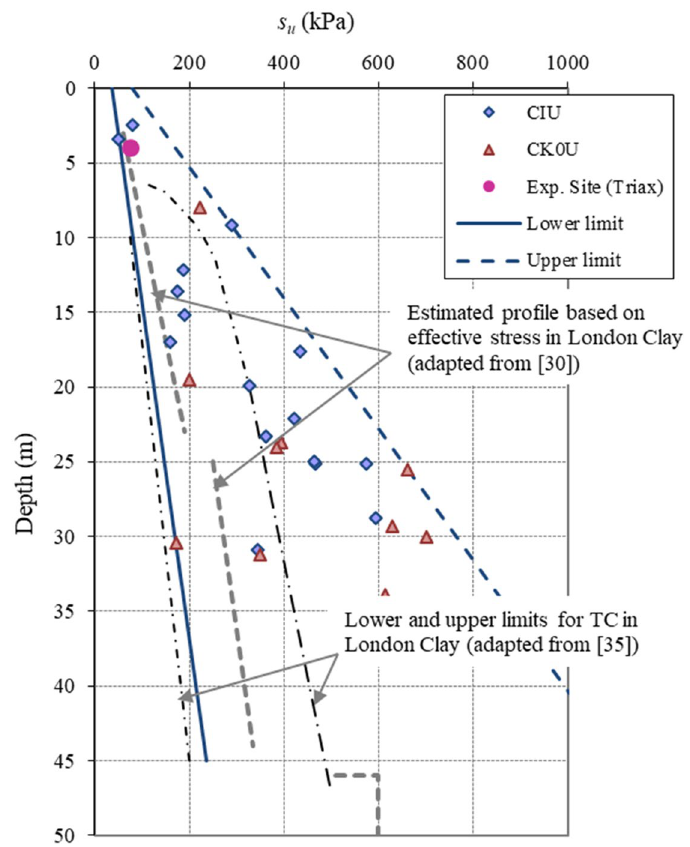
Fig. 14 Undrained shear strength from triaxial tests